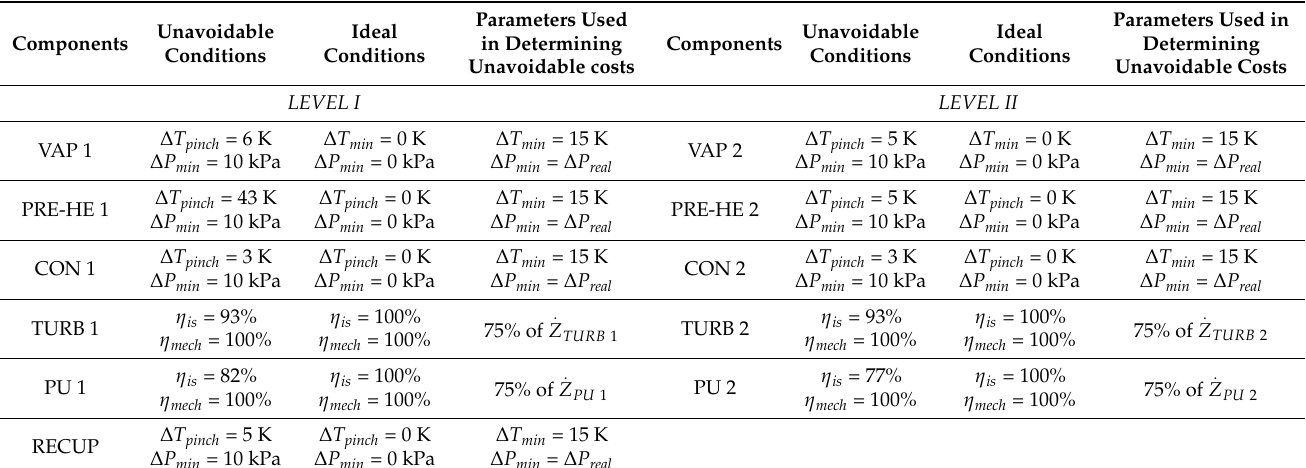
Table 2. The parameters utilized for the AdvExEcon analysis of the Sinem